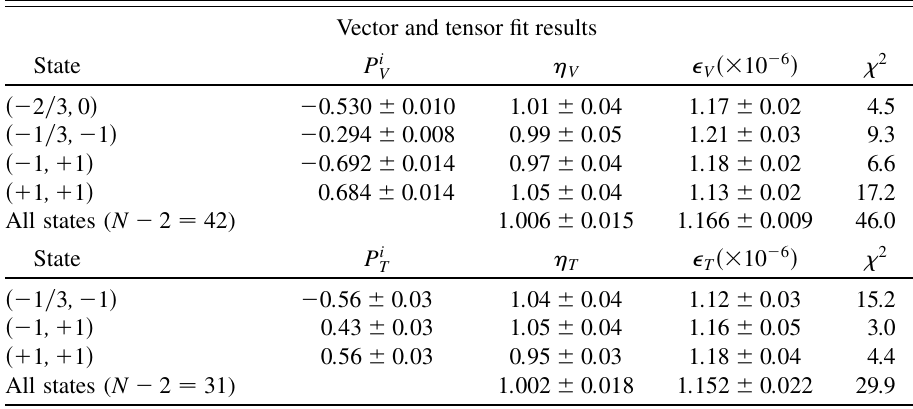
TABLE II. Fit results for Figs. 4 and 5. Vector and tensor fit results